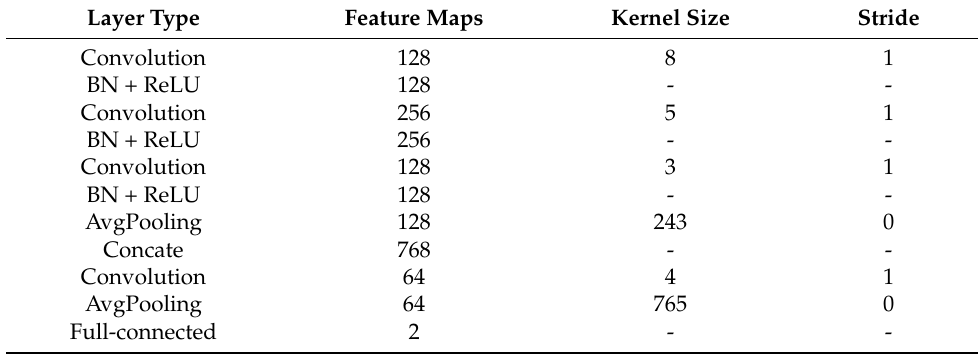
Table 1. Details of the the MCRNN structure.